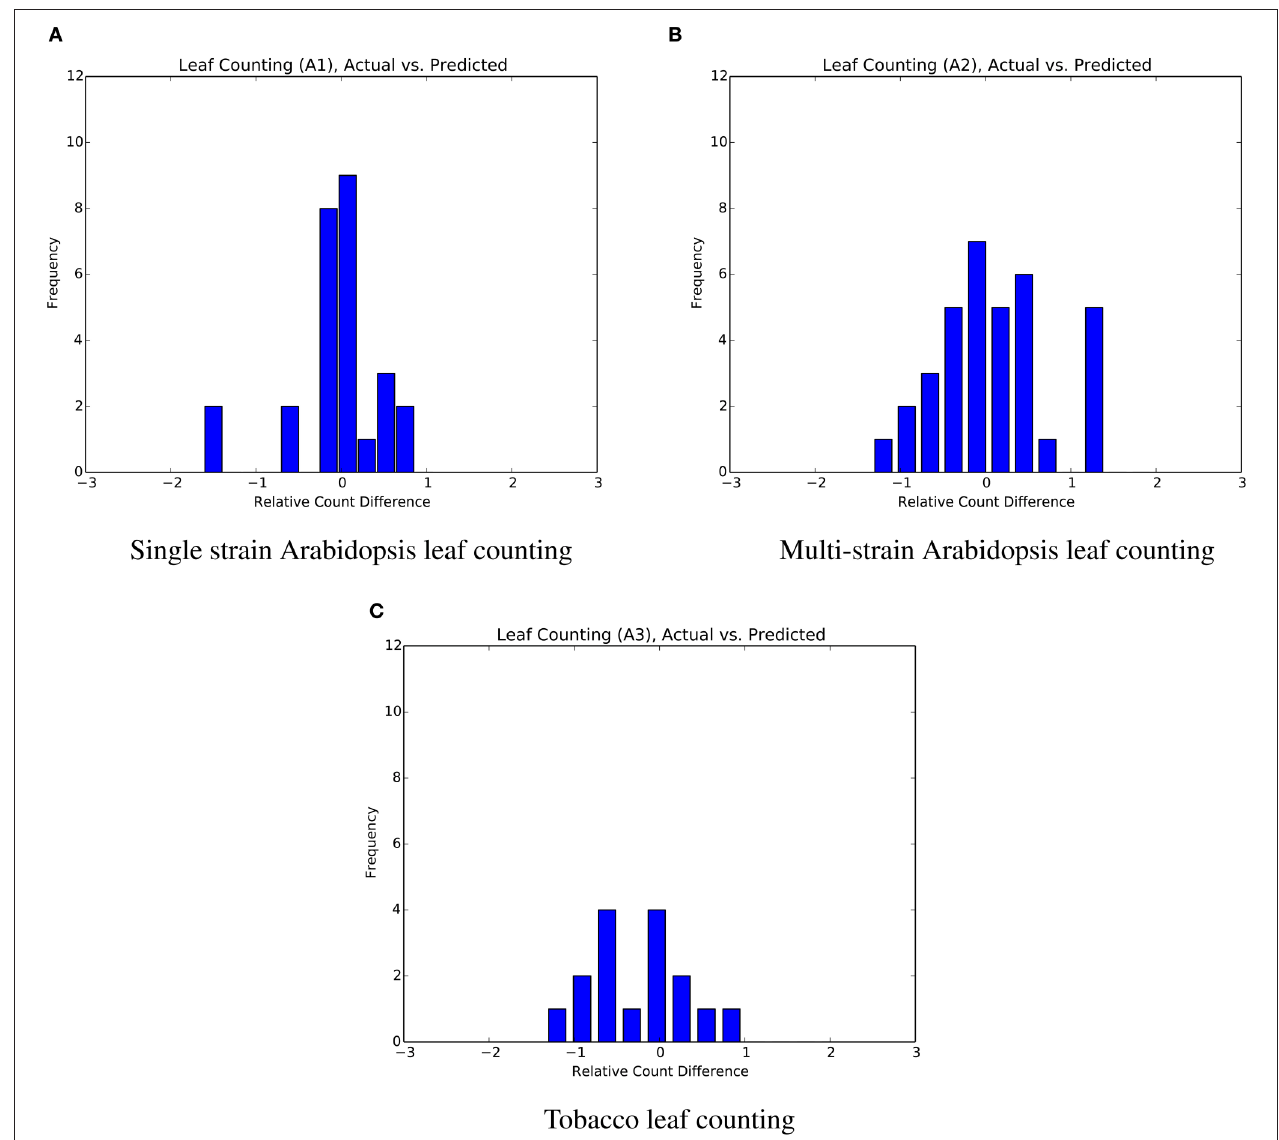
FIGURE 4 | Distribution of count errors for the three leaf counting datasets. The output of the regressor is not rounded in order to produce more granular bins. (A) Single strain Arabidopsis leaf counting. (B) Multi-strain Arabidopsis leaf counting. (C) Tobacco leaf counting.